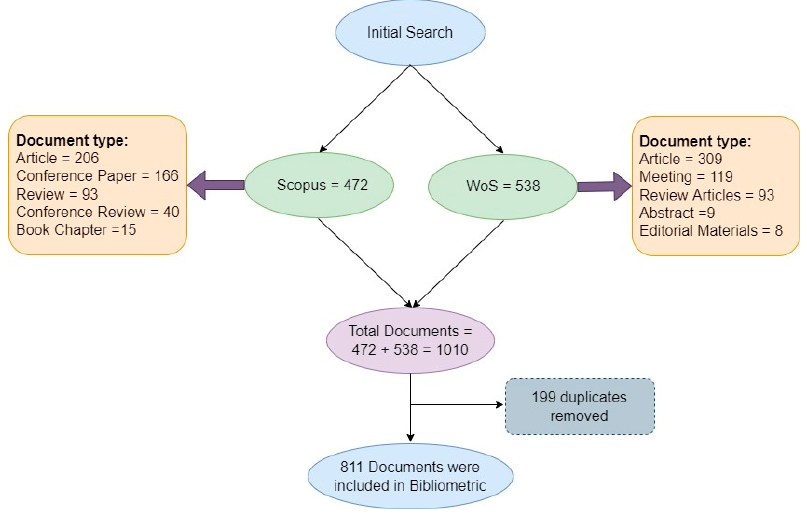
Figure 6. Search strategy.